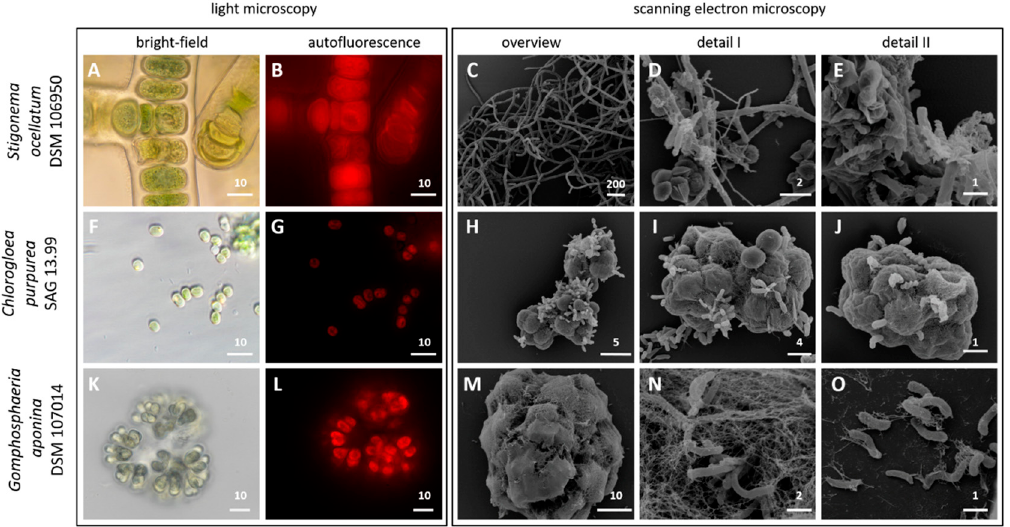
Figure 1. Light and scanning electron microscopy of three non-axenic cyanobacteria, i.e., Stigonema ocellatum DSM 106950 ( A – E ), Chlorogloea purpurea SAG 13.99 ( F – J ) and Gomphosphaeria aponina DSM 107014 ( K – O ). Scale bar for light microscopy: 10 µm ( A , B , F , G , K , L ). Scale bars for SEM overview: 200 µm ( C ), 5 µm ( H ), 10 µm ( M ); detail I: 2 µm ( D ), 4 µm (I), 2 µm (N) and detail II: 1 µm ( E , J , O ).